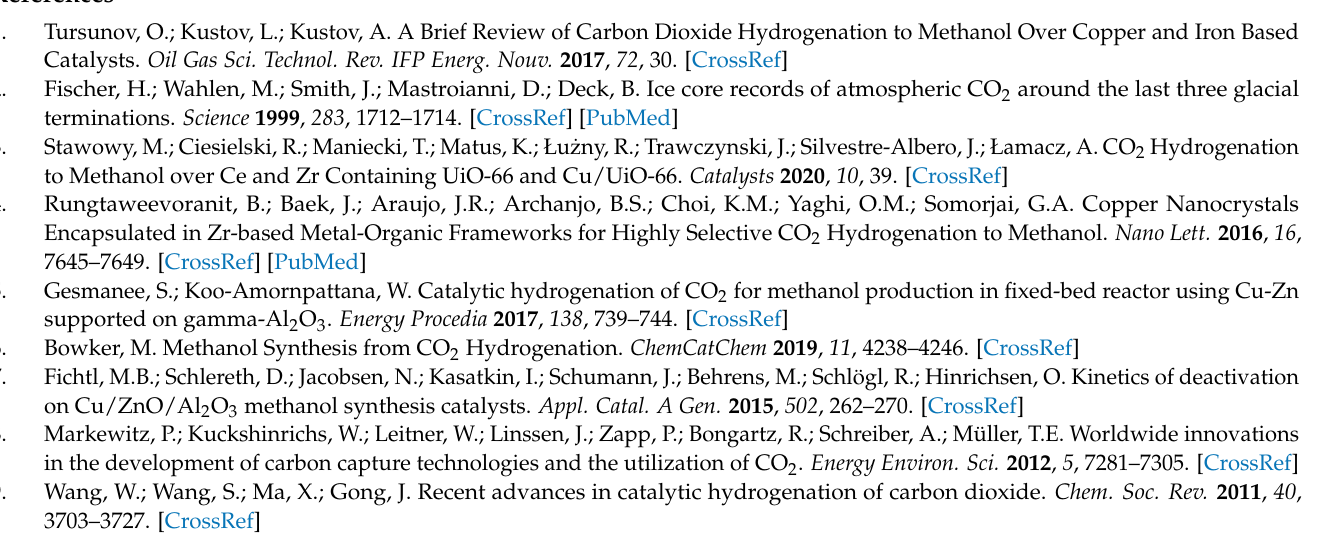
commercial catalyst; Figure S4: XPS results of UiO-66: (a) full survey, (b) Zr3d, and O1s